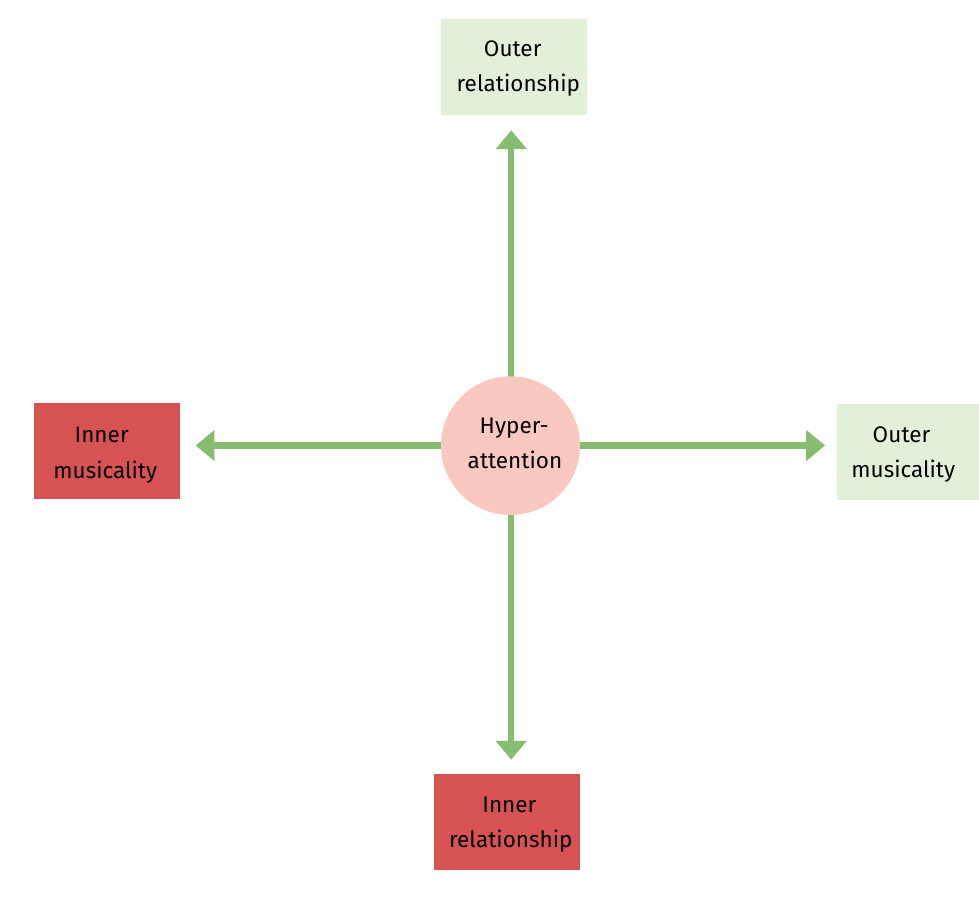
Figure 1.3. The Inner/Outer Musical-Relational